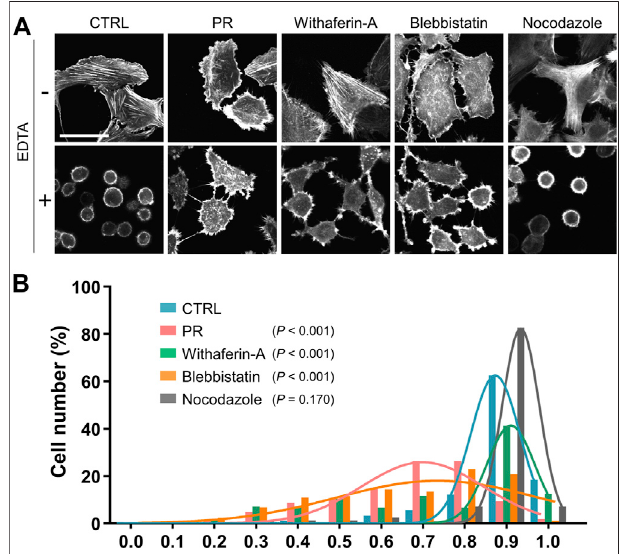
FIGURE 5 | PR 20 inhibits cell detachment by EDTA. (A) Representative LifeAct-GFP images of U2OS cells in CTRL and PR 20 -treated (PR) and the cytoskeletal inhibitors, Withaferin-A, Blebbistatin and Nocodazole treatment, following detachment by 5 µM EDTA. A bar is 50 µm. (B) A histogram of the cell circularity of U2OS cells after detachment by 5 µM EDTA in CTRL ( n = 179, blue), PR 20 ( n = 158, red), Withaferin-A ( n = 243, green), Blebbistatin ( n = 316, orange), and Nocodazole (n = 242, gray). A circularity of 1.0 indicates a complete circle. As it approaches 0.0, it indicates an elongated polygon. p value shows Welch ’ s t